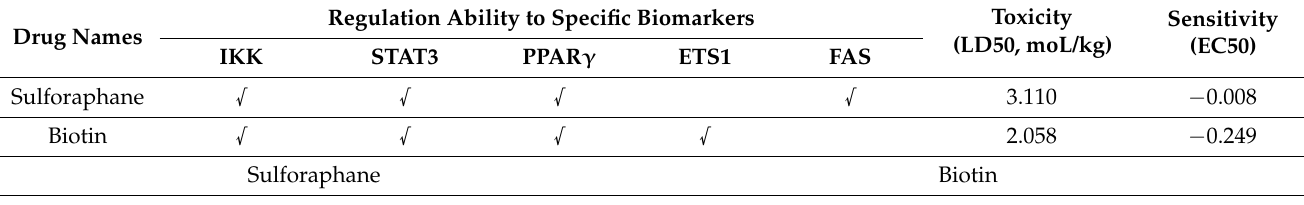
Chemical structures of multiple molecular drugs